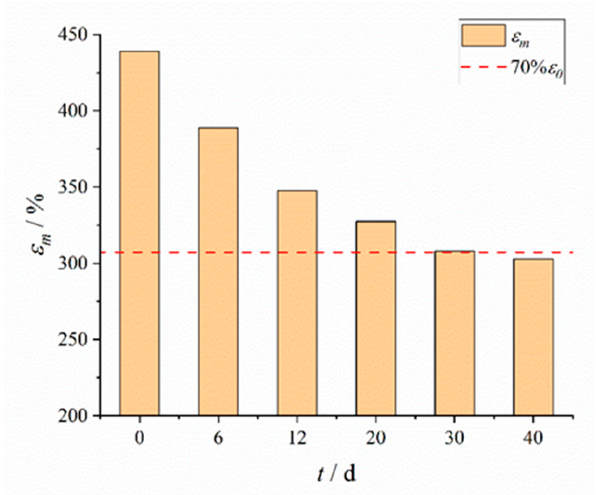
Figure 2. Aging results of maximum elongation of the HTPB coating.